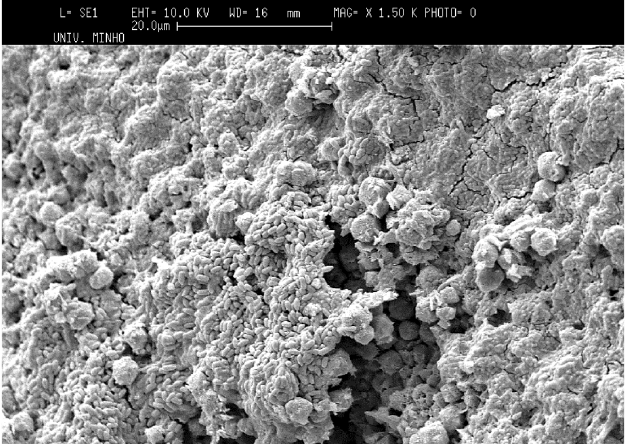
Figure 9. SEM image of the starting 13X zeolite: magnifications of 1000 × ( A ) and 3000 × ( B ).